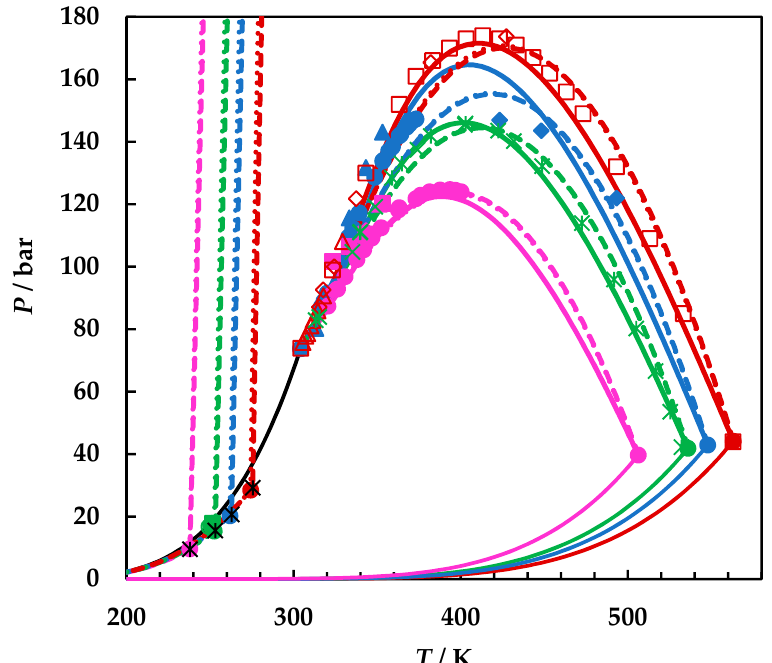
Figure 5. P – T fluid phase diagram of the carbon dioxide (1) + tert -butanol (2), carbon dioxide (1) + Figure 6. P – T fluid phase diagram of the carbon dioxide (1) + tert -butanol (2), + 2-butanol (2), + Figure 6. P – T fluid phase diagram of the carbon dioxide (1) + tert -butanol (2), + 2-butanol (2), 2-butanol (2), carbon dioxide (1) + isobutanol (2), and carbon dioxide (1) + 1-butanol (2) binary sys- Figure 6. P – T fluid phase diagram of the carbon dioxide (1) + tert -butanol (2), + 2-butanol (2), + isobutanol (2), and + 1-butanol (2) binary systems. Experimental data: CO 2 + tert -butanol ( ● , this + isobutanol (2), and + 1-butanol (2) binary systems. Experimental data: CO 2 + tert -butanol ( • , this tems. The symbols represent the binary systems as follows: CO 2 + tert -butanol ( ● , this work; ■, [28]; isobutanol (2), and + 1-butanol (2) binary systems. Experimental data: CO 2 + tert -butanol ( ● , this work; ■, [28]; ▲, [29]; ◆, [30]); + 2-butanol ( ✱ , [48]; × , [49]); + isobutanol ( ● , this work; ▲, [27]; ◆, ▲, [29]; ◆, [30]); CO 2 + 2-butanol ( ✱ , [48]; × , [49]); CO 2 + isobutanol ( ● , this work; ▲, [27]; ◆, [26]); work; (cid:4) , [28]; (cid:78) , [29]; (cid:7) , [30]); + 2-butanol work; ■, [28]; ▲, [29]; ◆, [30]); + 2-butanol ( ✱ , [48]; × , [49]); + isobutanol ( ● , this work; ▲, [27]; ◆, [26]); + 1-butanol ( ∆ , [52]; □ , [50]; ◊ , [51]). Model results: GEOS (full lines); PR (dotted lines); SRK CO 2 + 1-butanol ( ∆ , [52]; □ , [50]; ◊ , [51]). [26]); + 1-butanol ( ∆ , [52]; □ , [50]; ◊ , [51]). Model results: GEOS (full lines); PR (dotted lines); SRK (dashed lines). (dashed lines).